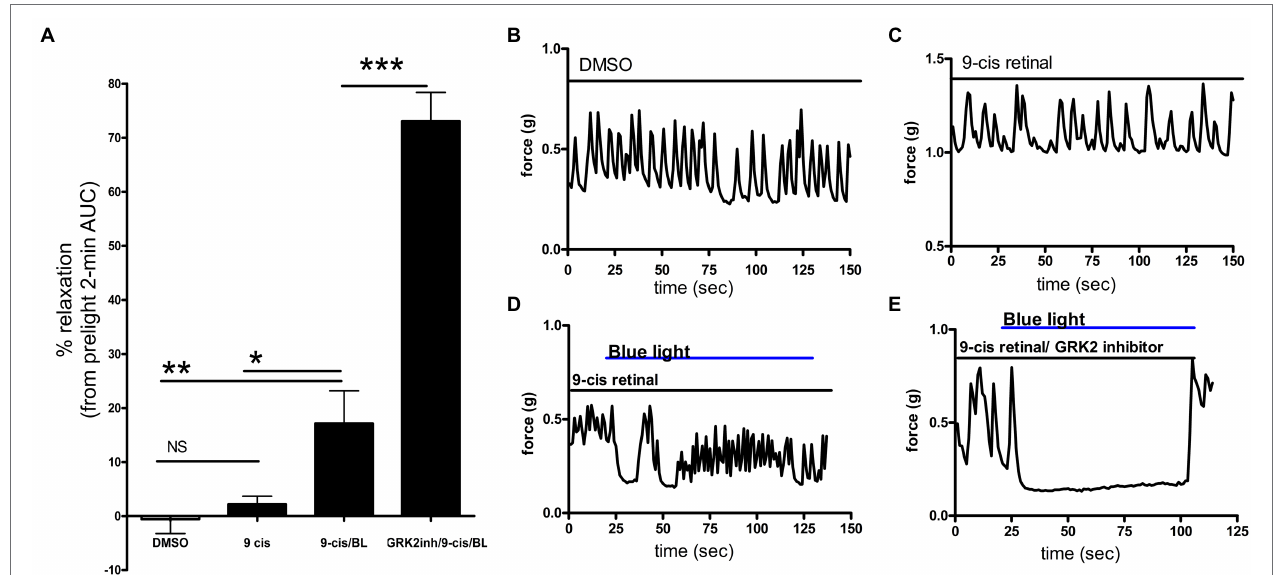
FIGURE 2 | (A) Area under the curve analysis of ex vivo murine colon rings precontracted with carbachol with pretreatment with DMSO, 9 -cis retinal or 9 -cis retinal + G protein receptor kinase 2 (GRK2) inhibitor followed by no light or BL treatment. Rings treated with 9 -cis retinal and blue light exhibited significantly more relaxation (17 ± 6.0%) vs. rings only pretreated with 9 -cis (2.2 ± 1.5%) and vehicle-pretreated rings not treated with light (* p < 0.05, ** p < 0.01, n = 8–12 rings per group). Colonic rings pretreated with a GRK2 inhibitor + 9 -cis retinal followed by blue light exposure demonstrated significantly greater photorelaxation (73 ± 5.3%) compared to rings pretreated with 9 -cis retinal alone and blue light. (*** p < 0.001, n = 8–15 rings per group). (B–E) Representative muscle force tracings of ex vivo murine colon rings pretreated with TTX 1 μ M and contracted with carbachol 100 μ M in wire myography experiments. Colon segments were pretreated with 0.1% DMSO vehicle, 9 -cis retinal 28 μ M, or 9 -cis retinal + GRK-2 inhibitor (20 μ M) and exposed to blue light (435 nm λ ). Solid bars indicate the duration of the